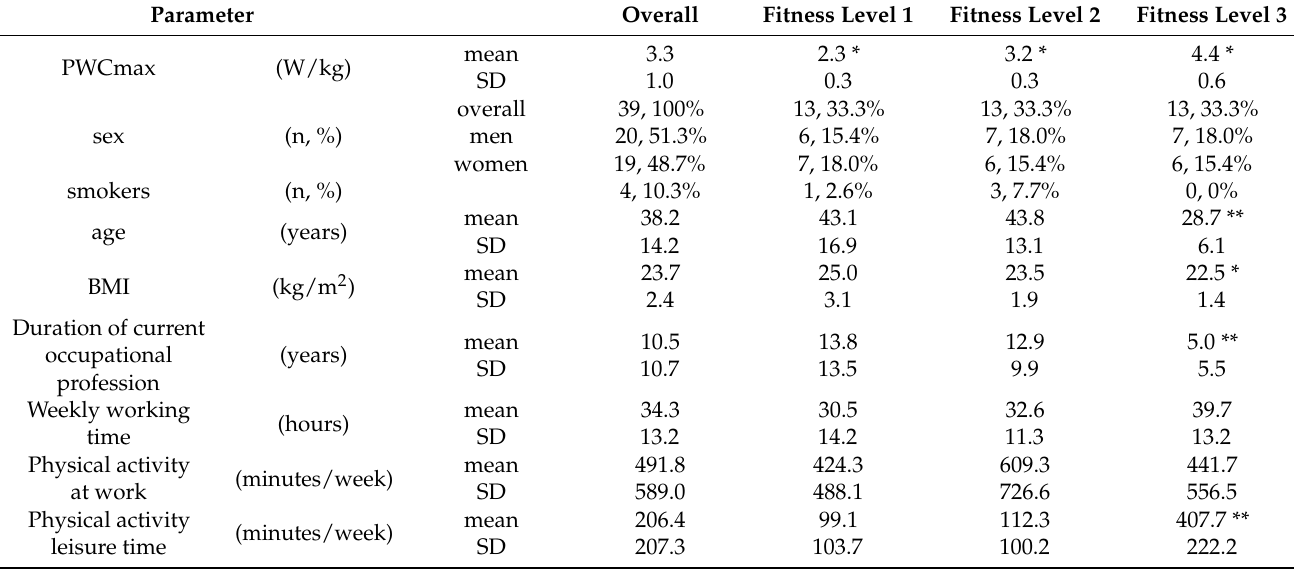
Table 1. Characteristics of the study